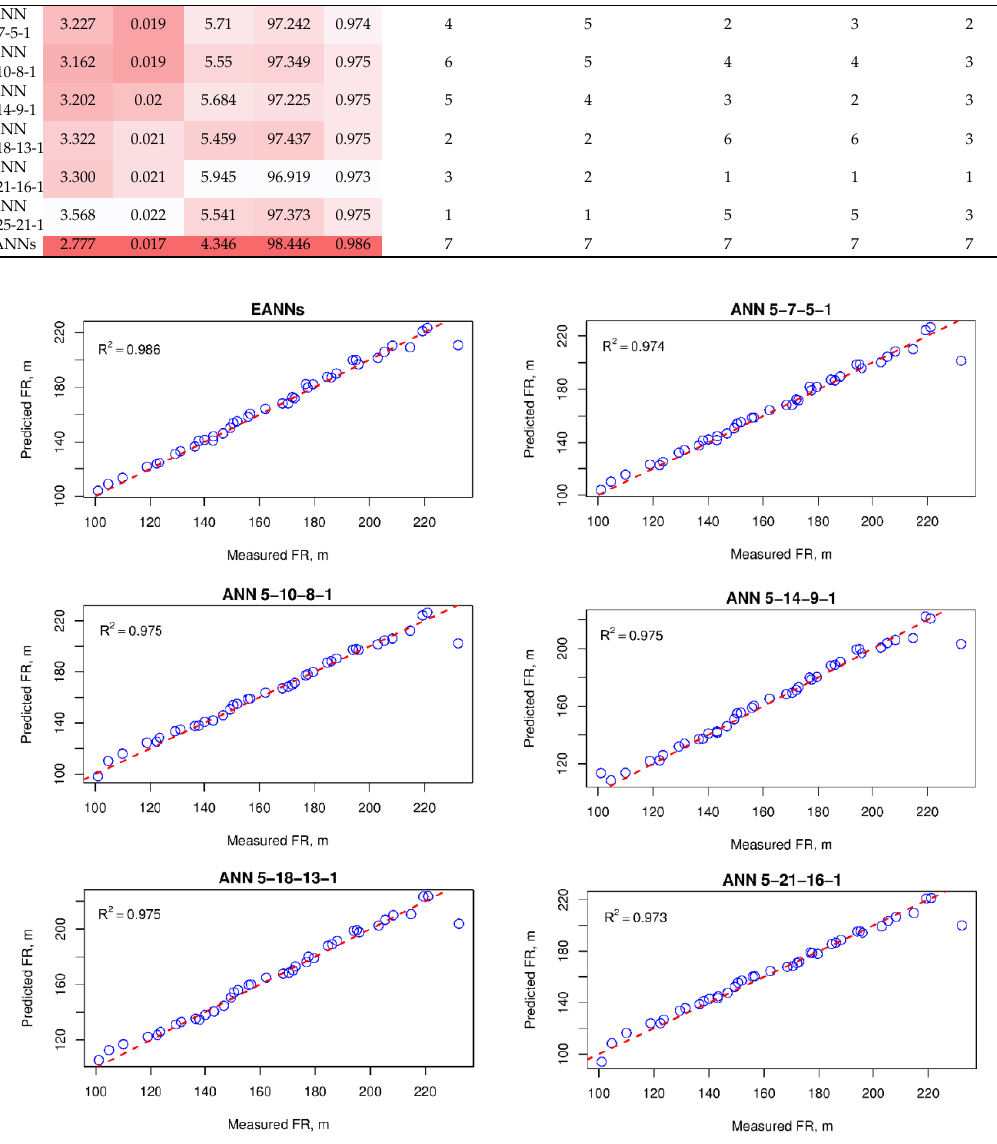
Figure 8. Accuracy of di ff erent ANN and EANNs models in estimating fly-rock.